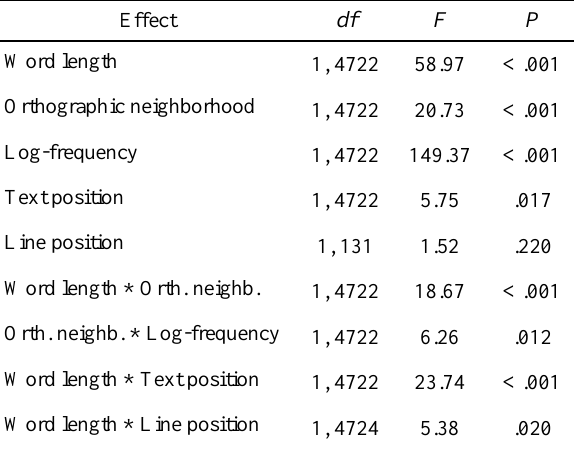
Table 4. Total reading time: ANOVA